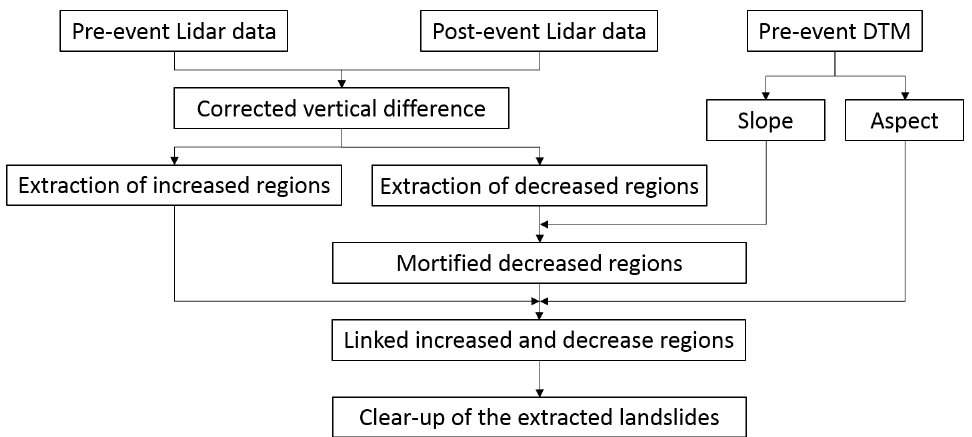
Figure 7. Flowchart of the proposed method to detect landslides using pre- and post-event Lidar data.